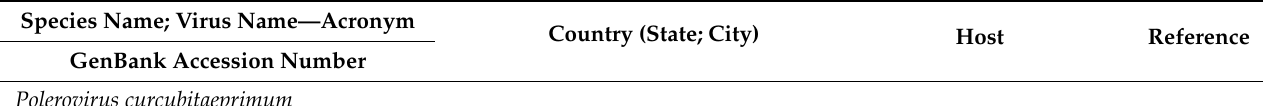
Table 1. Suggested classification for the cucurbit aphid-borne yellows